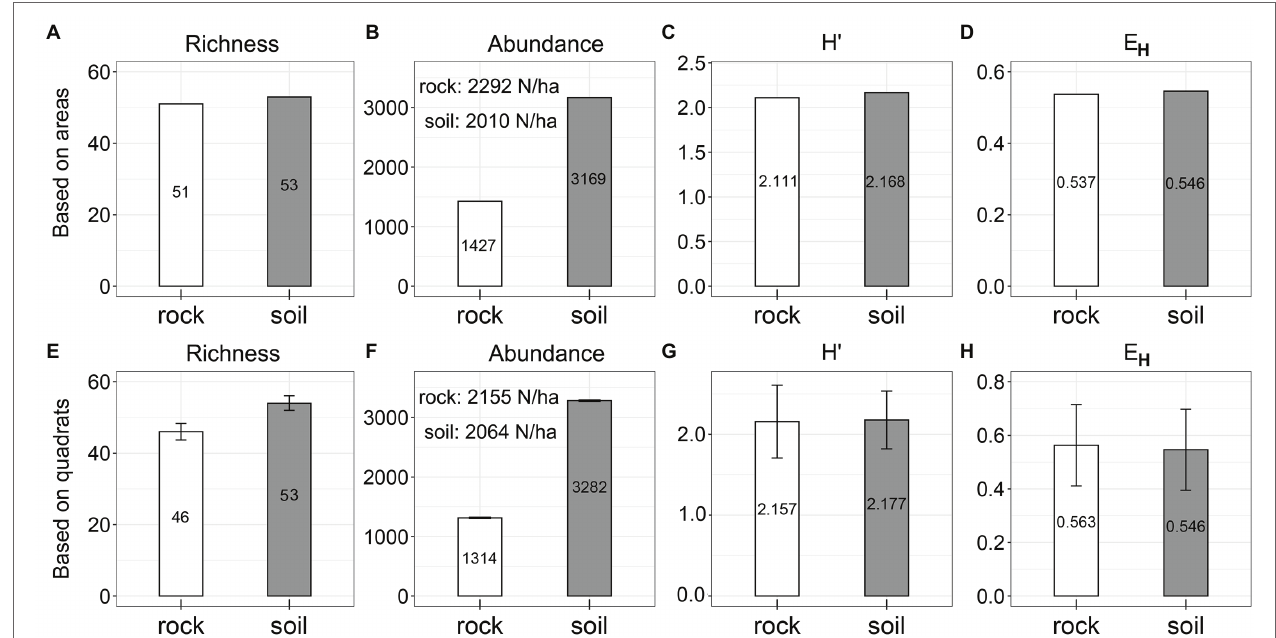
FIGURE 2 | Species diversity on rock and soil. H ′ = ShannonWiener index, and E H = Pielou evenness index.